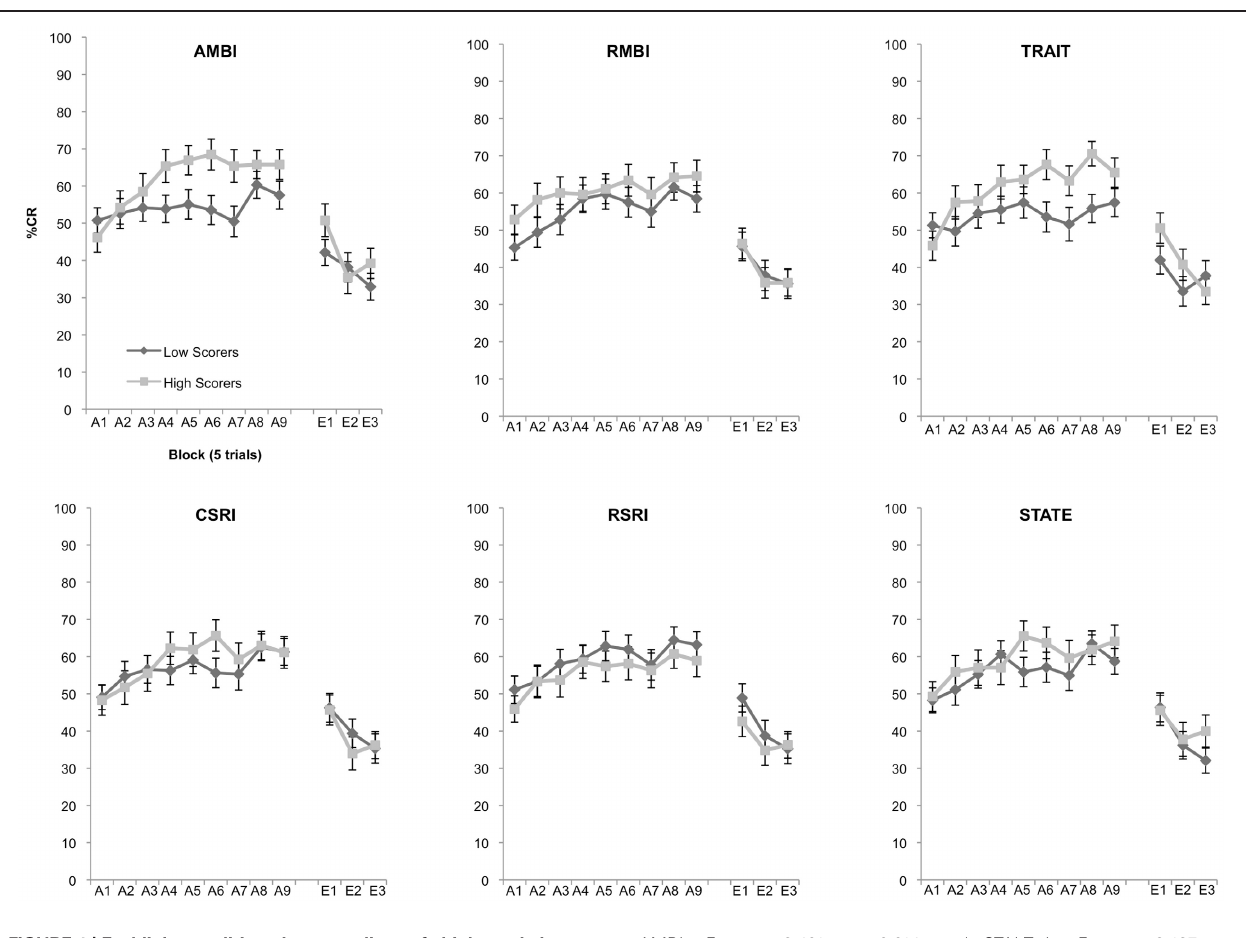
FIGURE 1 | Eyeblink conditioned responding of high and low scoring groups. Significant differences of acquisition of the CR between high and low scoring groups were observed in the